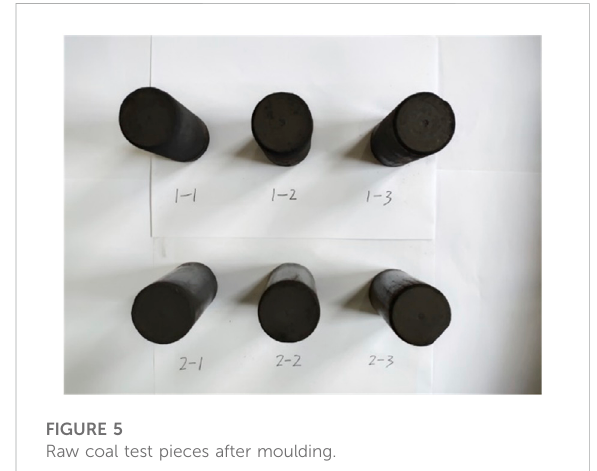
FIGURE 5 Raw coal test pieces after moulding.